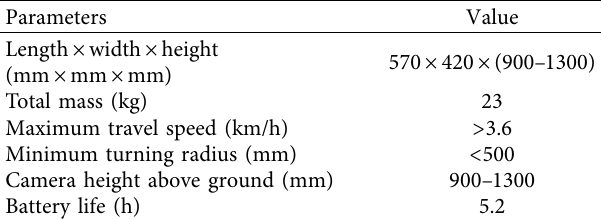
Figure 1: Overall structure of the robot. (1) Multi-terrain replacement chassis. (2) Surveillance camera. (3) Lidar. (4) Camera module. (5) Electronic control lift image acquisition bracket. (6) Car display. (7) Quick release mechanism. Table 1: Main parameters of the